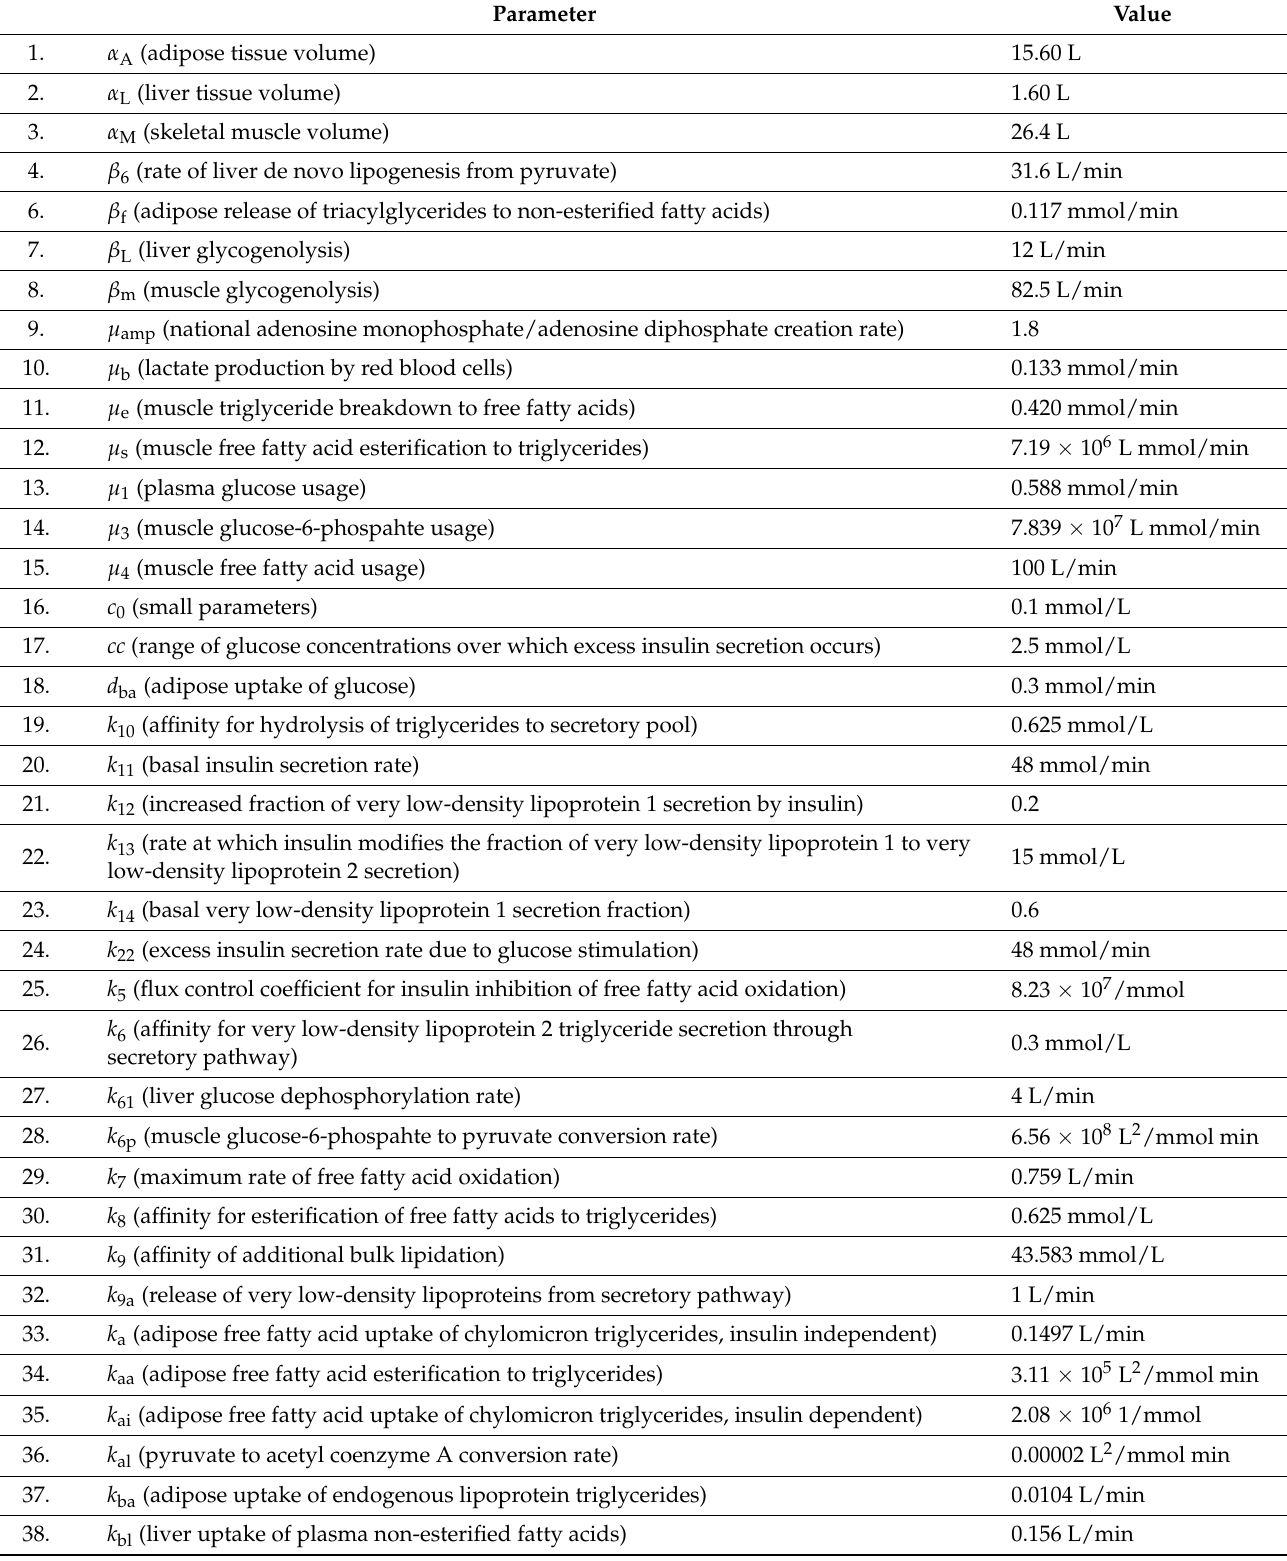
Table 3. List of hepatic lipid metabolism model parameters proposed by Pratt et al.